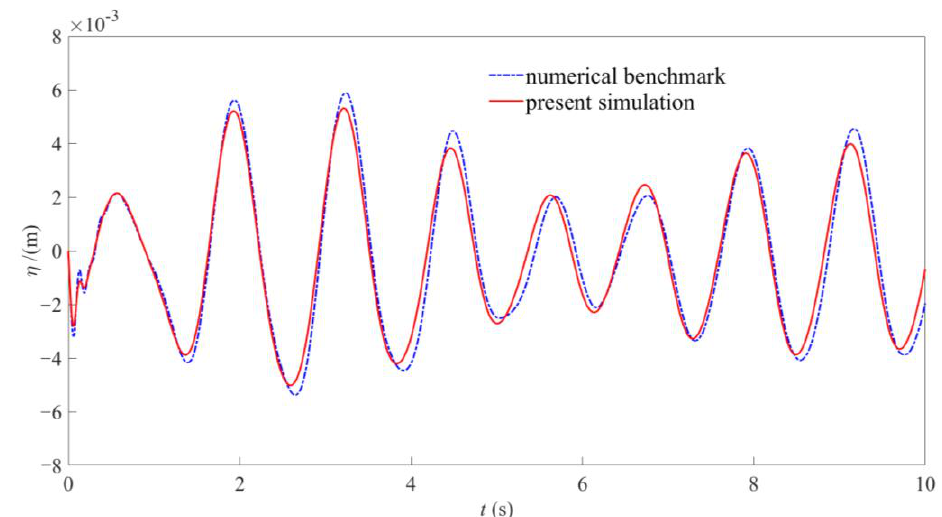
Figure 6. Comparison of the time history of free surface elevation at y = 0 between the results of the present simulation and numerical benchmark of Liu and Lin [35].